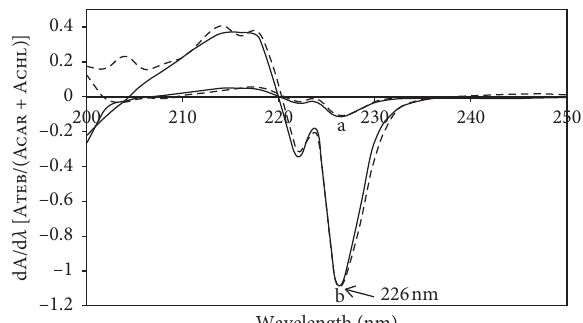
Figure 5: The coincident spectra of the first derivative of the ratio spectra of (a) 5 μ g/mL pure TEB ( ___ ) and 5 μ g/mL TEB in a ternary mixture (-----), and (b) 45 μ g/mL pure TEB ( ___ ) and 45 μ g/mL TEB in a ternary mixture (-----) in methanol using 5 μ g/mL CAR +5 μ g/mL CHL as a double divisor at Δ λ � 2.